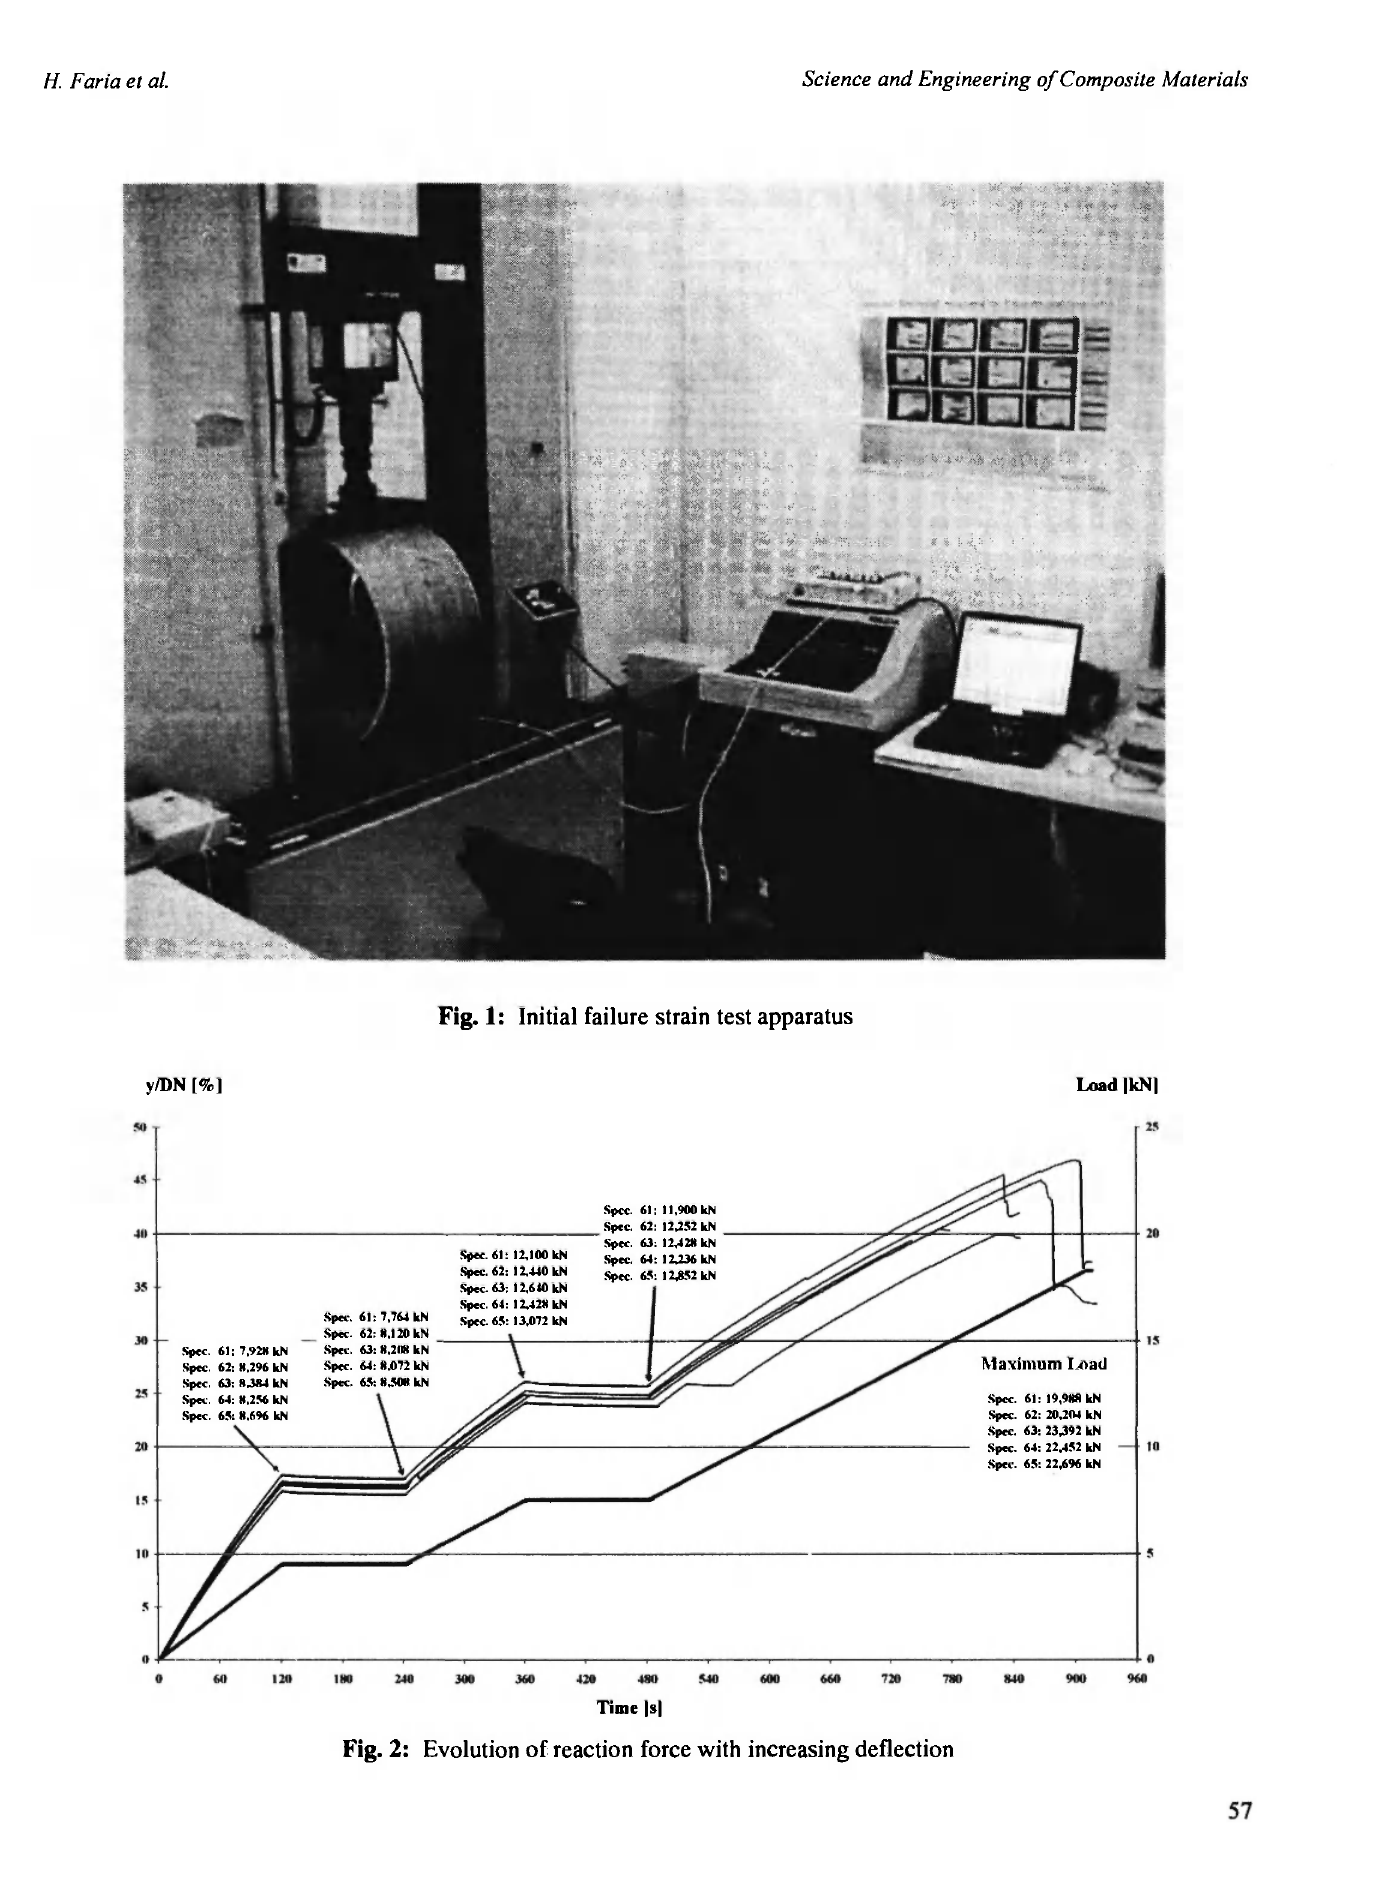
Fig. 1: Initial failure strain test apparatus